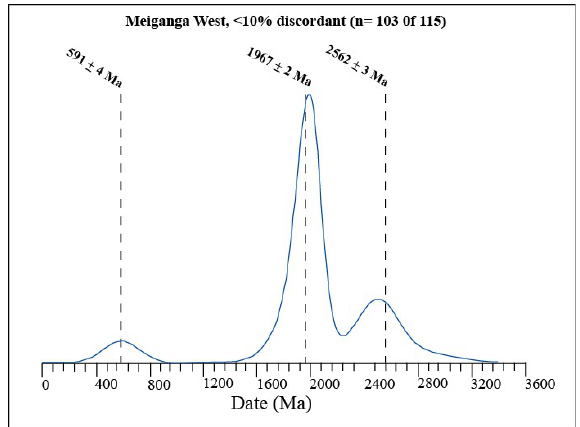
Figure 5. U–Pb discordia diagram for the western Meiganga detrital zircons.